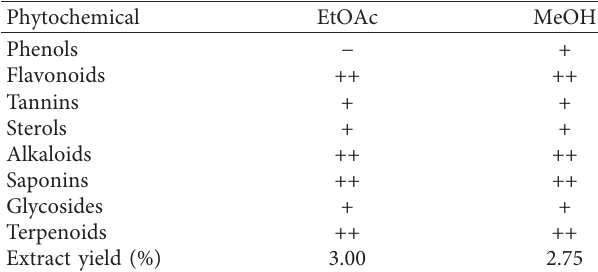
Figure 2: ED 50 and ED 90 at passage 16 (ethyl acetate extract against P. berghei ANKA). Table 8: Qualitative phytochemical investigation of the five ex- tracts of N. sativa